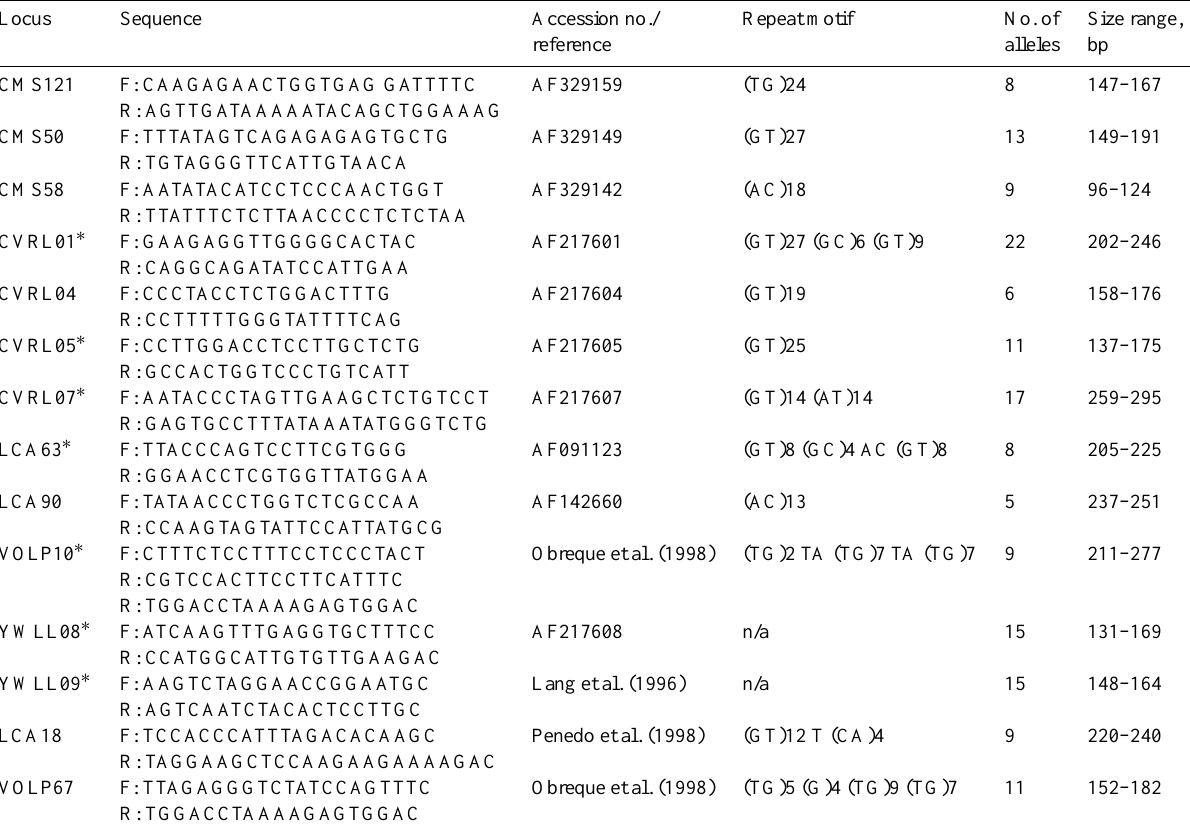
Table 1. Characteristics of microsatellite marker loci used in the current study. Locus